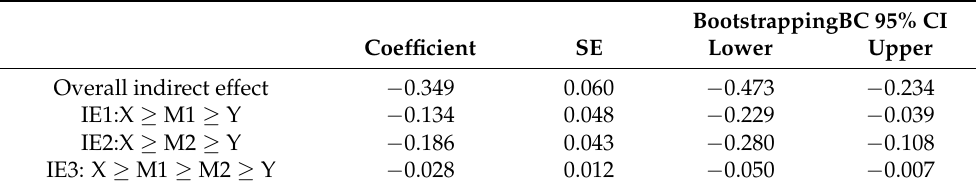
Table 4. Indirect effects of the serial multiple mediator model of the effect of role ambiguity (x) on extra-role behavior (Y) through engagement (M1) and leader support (M2). BootstrappingBC 95% CI Coefficient SE Lower Upper Overall indirect effect − 0.349 0.060 −